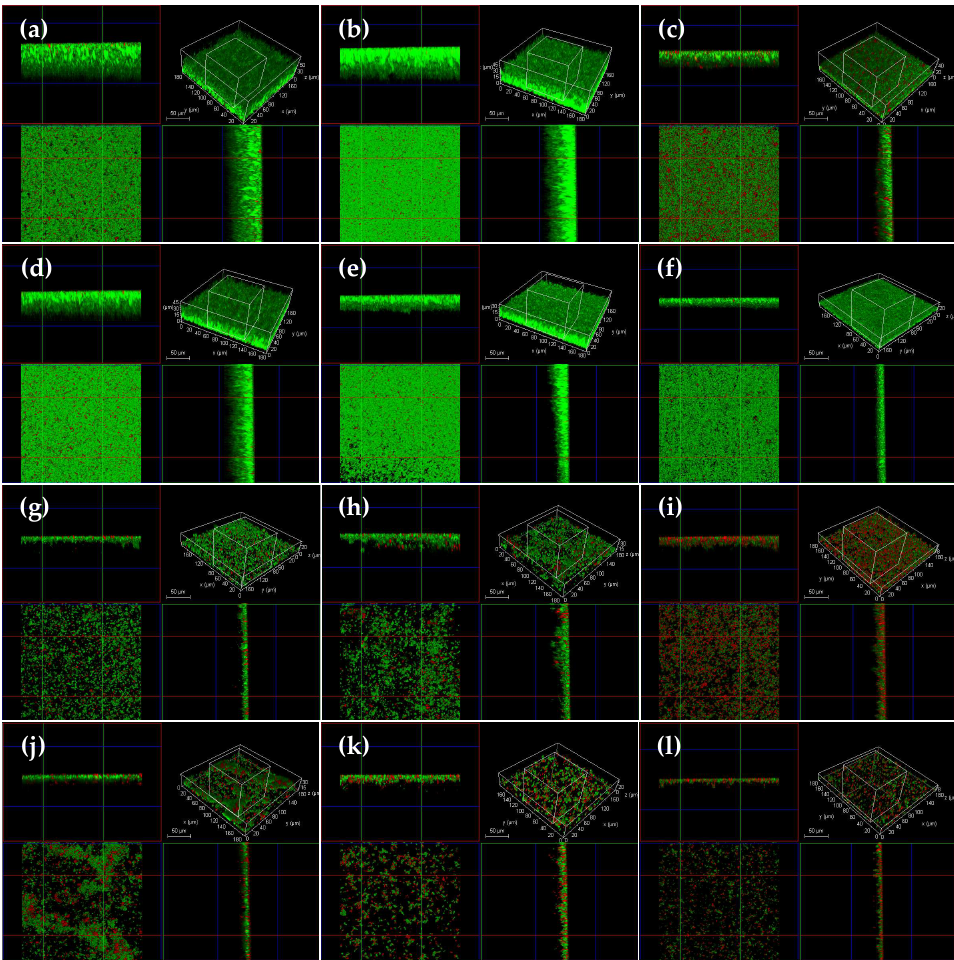
Figure 3. CLSM analysis of mature T. pyogenes (BMH06-3) biofilm disruption treated with 312 µ g/mL luteolin (Green: live bacteria; red: killed bacteria; black: no bacteria). ( a ) Blank control biofilm. ( b ) Solvent control biofilm (1% DMSO). ( c ) Mature biofilm treated with ceftiofur (0.25 ng/mL) for 24 h. ( d – l ) Mature biofilm treated with 312 µ g/mL luteolin for 2, 4, 6, 8, 10, 12, 16, 20 and 24